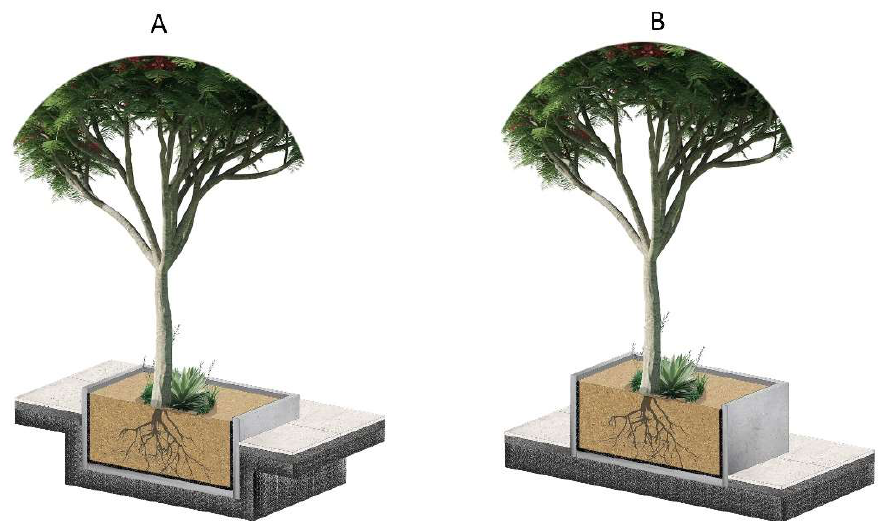
Figure 1. Planter types for implementing trees on buildings. ( A ) = sunken planter and ( B ) = raised Planter types for implementing trees on buildings. planter. ( B ) = raised